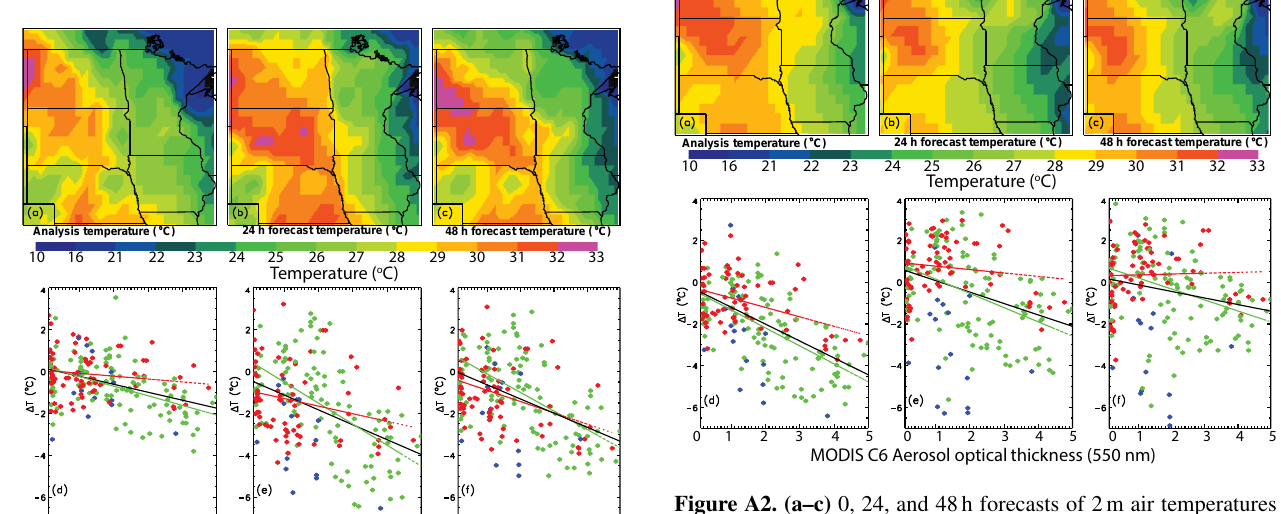
Figure A2. (a–c) 0, 24, and 48h forecasts of 2m air temperatures for the study region as shown in Fig. 3a at 18:00UTC, 29 June 2015, from NCEP model runs. (d–f) The differences between surface ob- servations (using ground stations as shown in Fig. 3c) and NCEP- modeled 2m temperatures (at 18:00UTC, 29 June 2015) as a func- tion of Collection 6 Terra MODIS DT τ 550 . Others are similar